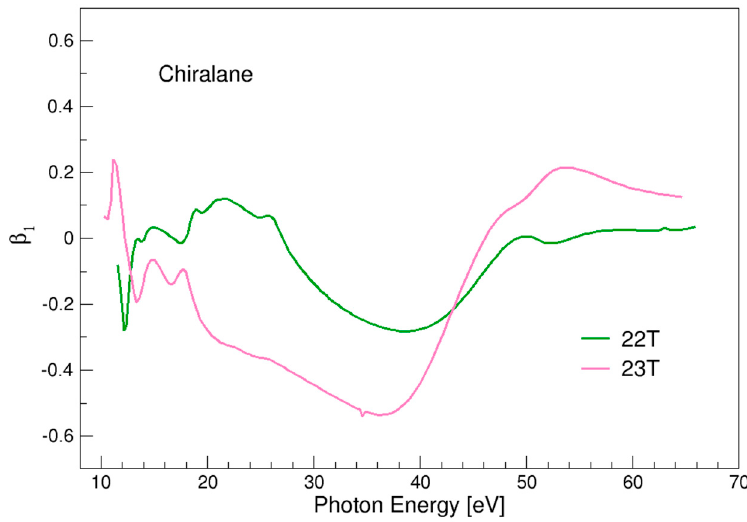
Figure 10. β 1 parameter for the two outermost ionizations, 23T and 22T, and the average value, in chiralane.